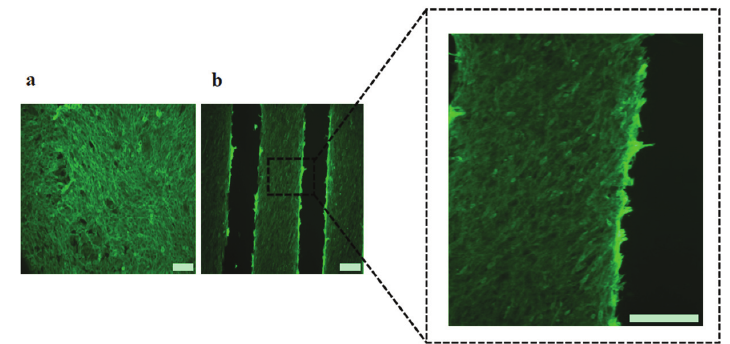
Figure 4. Fluorescent images showing arrangement of actin filaments after five days culture of C2C12 cells on ( a ) TCPS substrates or ( b ) micropatterned GlcNAc6-SAM. Actin filaments were stained with phalloidin (green) and the characteristic morphology of densely packed bundles of actin filaments was clearly evident in cells cultured on micropatterned GlcNAc6-SAM, as shown in a dashed box. Scale bars correspond to 200 μm.